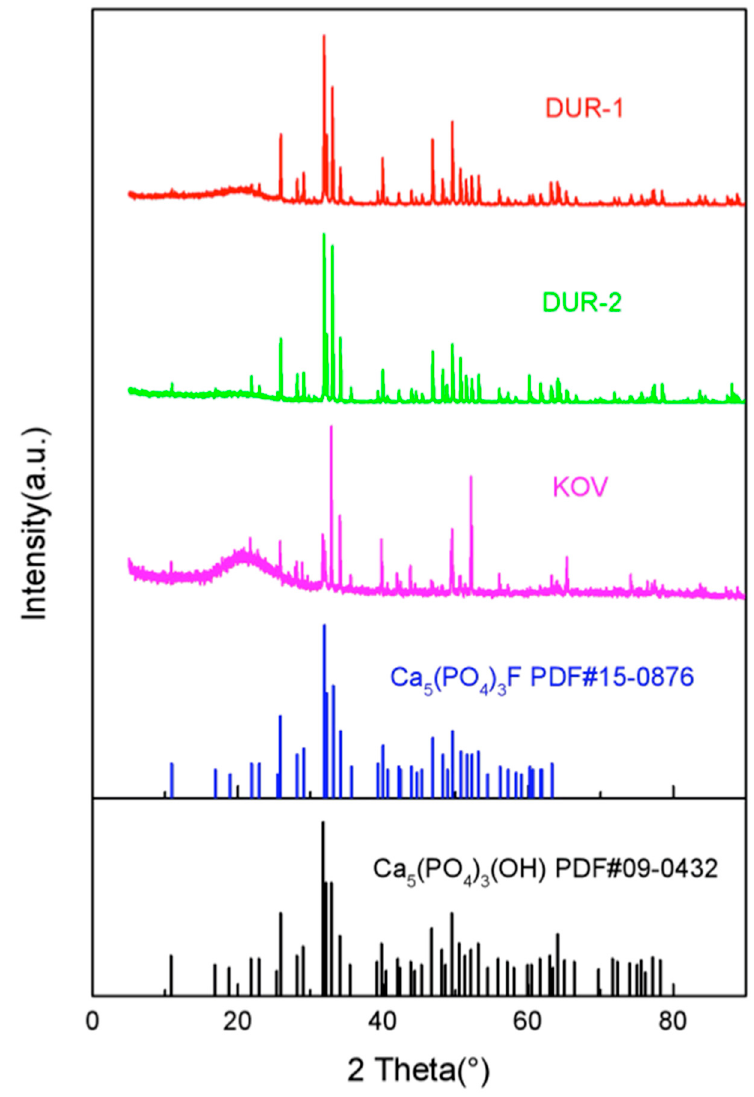
Crystals 2020 , 10 , x FOR PEER REVIEW Figure 2. XRD spectra of the Durango and Kovdor apatites. Figure 2. XRD spectra of the Durango and Kovdor apatites.